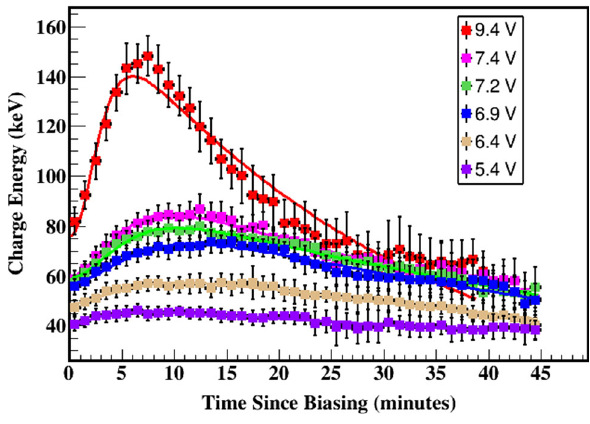
Fig. 7 Shown is the detected charge energy created by impact ioniza- tion as a function of applied bias voltage from Run 74 fitted by Eq. (1). The error bars represent the vertical width of the band shown in